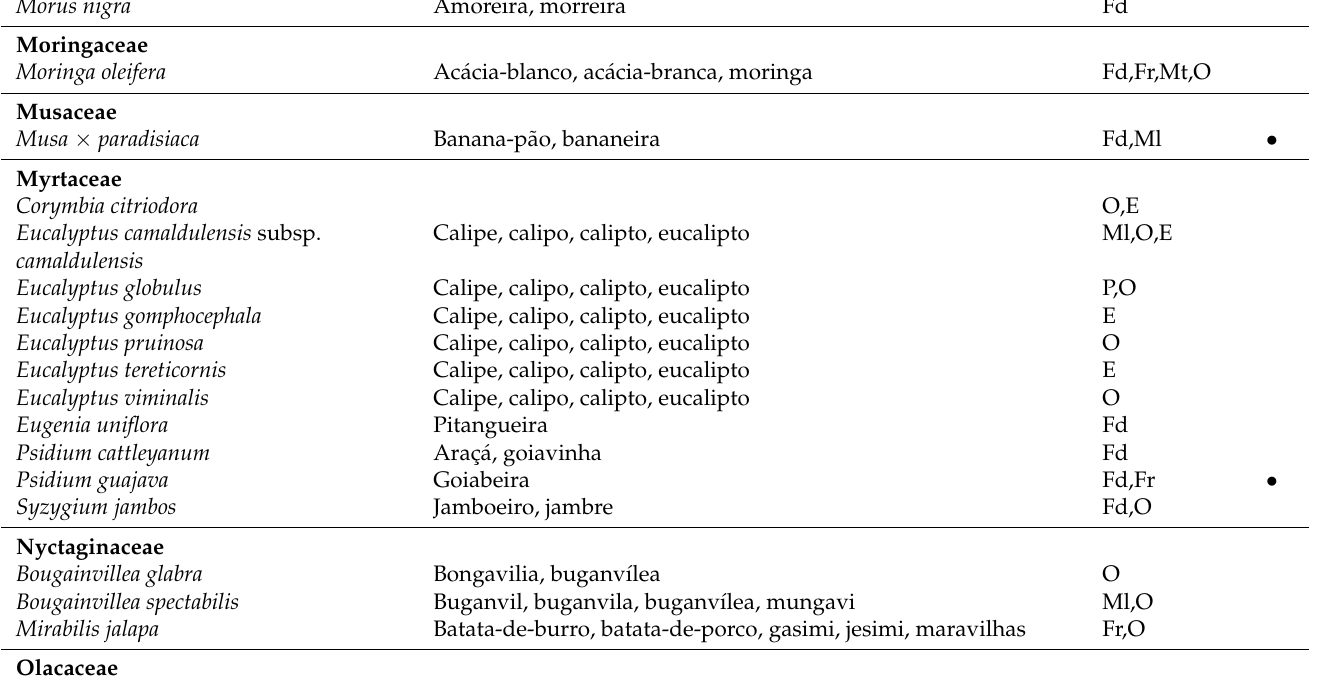
Figueira-de-goa, figueira-da- í